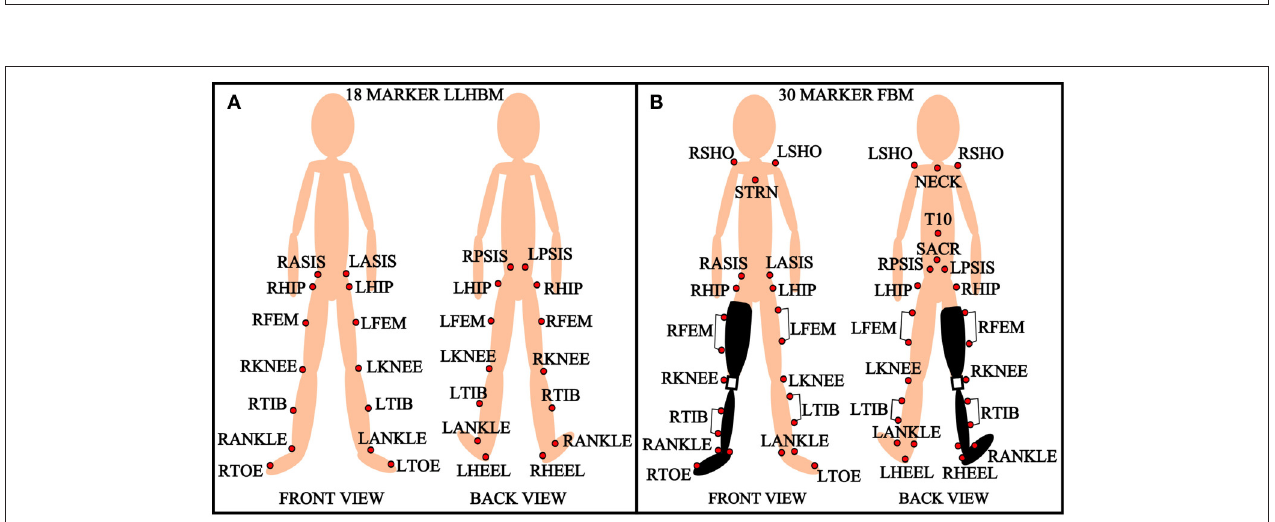
FIGURE 2 | Marker setup. (A) 18 marker lower limb human body model (LLHBM) and (B) 30 marker full body model (FBM). R, right; L, left; ASIS, anterior superior iliac spine; PSIS, posterior superior iliac spine; FEM, femur; TIB, tibia; STRN, sternum; SACR, sacral wand marker; SHO, shoulder.